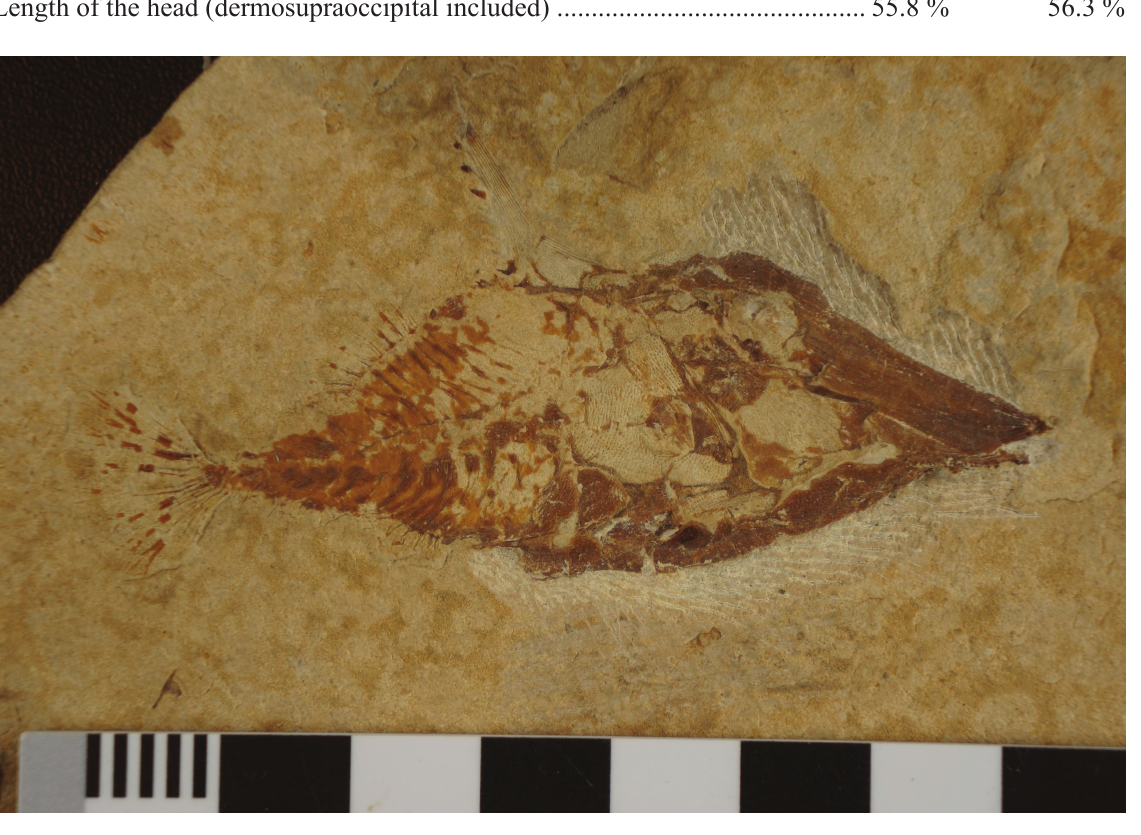
Fig. 1. Joinvillichthys lindstroemi (Davis, 1890). Holotype, NRM PZ